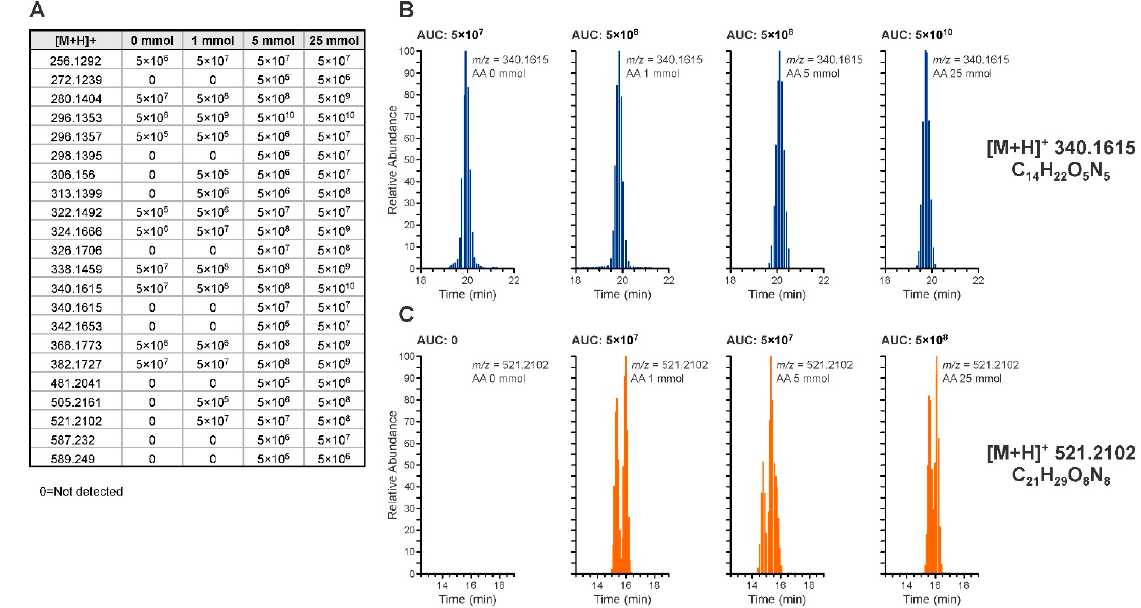
Figure 4. Concentration-dependent formation of the 22 DNA adducts identified in CT-DNA exposed to acetaldehyde. Panel A : ions detected during the adductomic screening and the average signal intensities at increasing acetaldehyde concentrations (0, 1, 5, and 25 mmol). Chromatograms from two representative DNA adducts among those identified are reported illustrating the increase in signal intensity measured as the area under the curve. Panel B : extracted ion chromatogram of m/z 340.1615 at increasing acetaldehyde concentrations. Panel C : extracted ion chromatogram of m/z 521.2102 at increasing acetaldehyde concentrations.